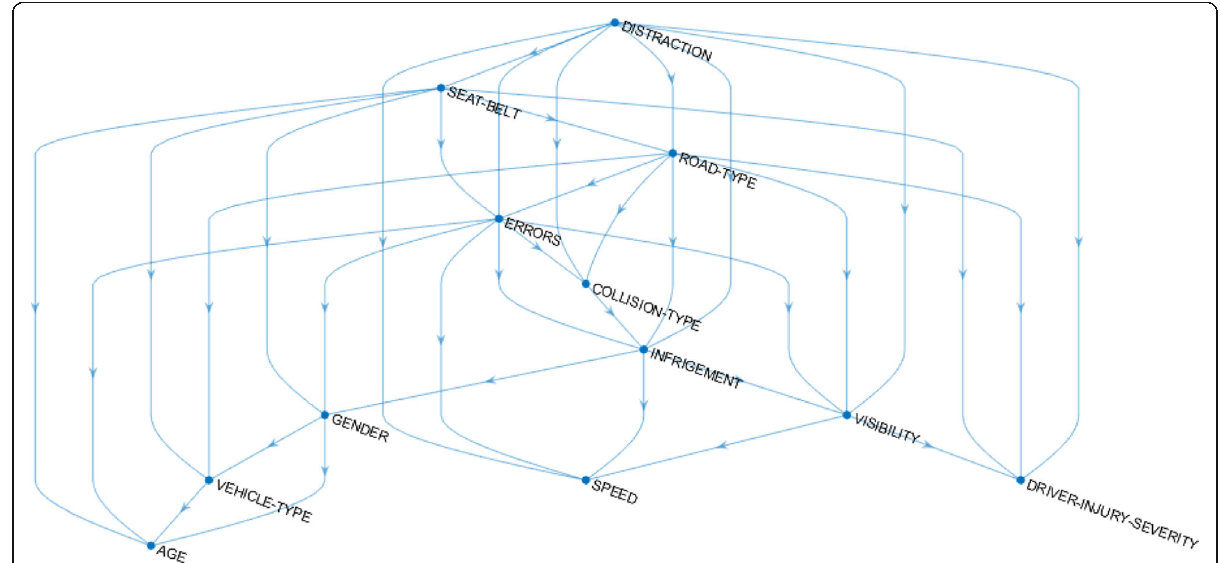
Fig. 3 Bayesian network. Processed by the